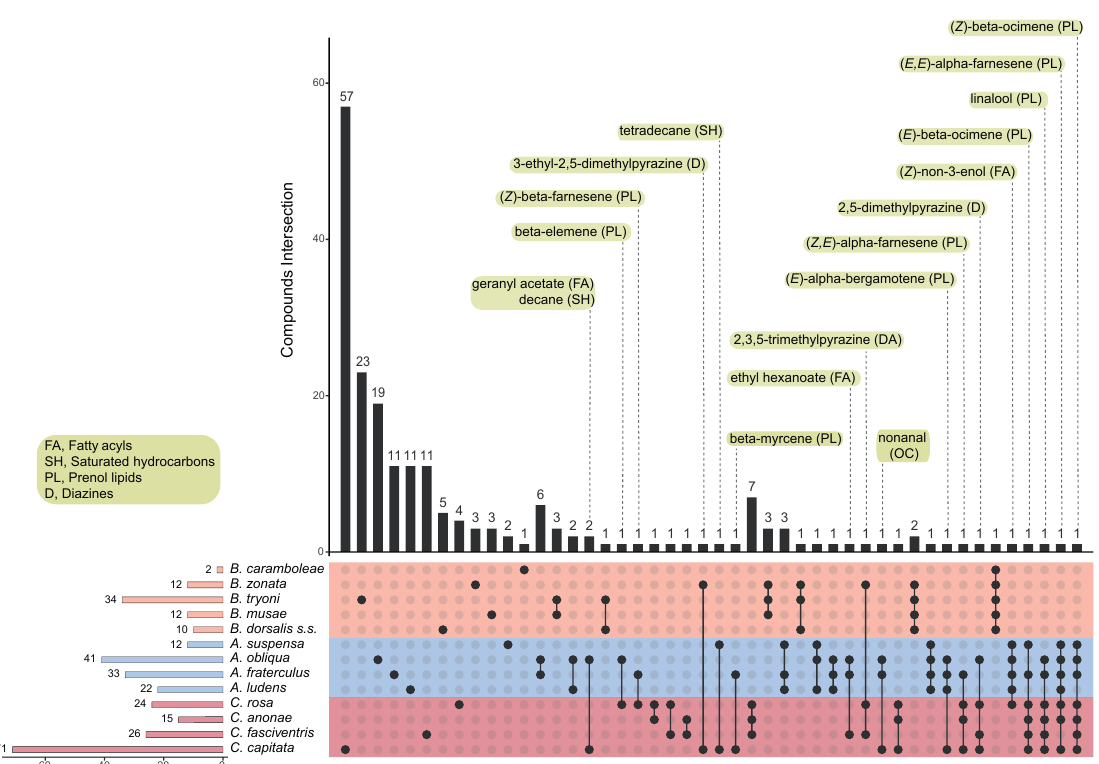
Figure 6. Comparison among the chemicals identified in the headspace emissions of polyphagous tephritid species. UpSet plot showing unique and overlapping chemicals across five species belonging to the Bactrocera , Anastrepha and Ceratitis genera. The intersection matrix is sorted in descending order. Different genera are indicated in different colors. Connected dots represent intersections of overlapping chemicals and horizontal bars show the total number of compounds identified in each species headspace. The plot was generated using the UpSetR package in R